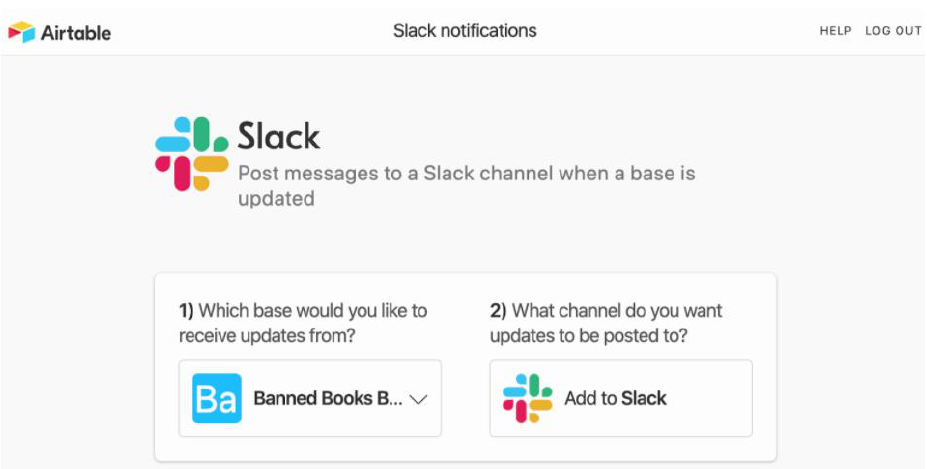
Figure 2. Airt able offers a simple avenue for communication through your organization’ s shared slack